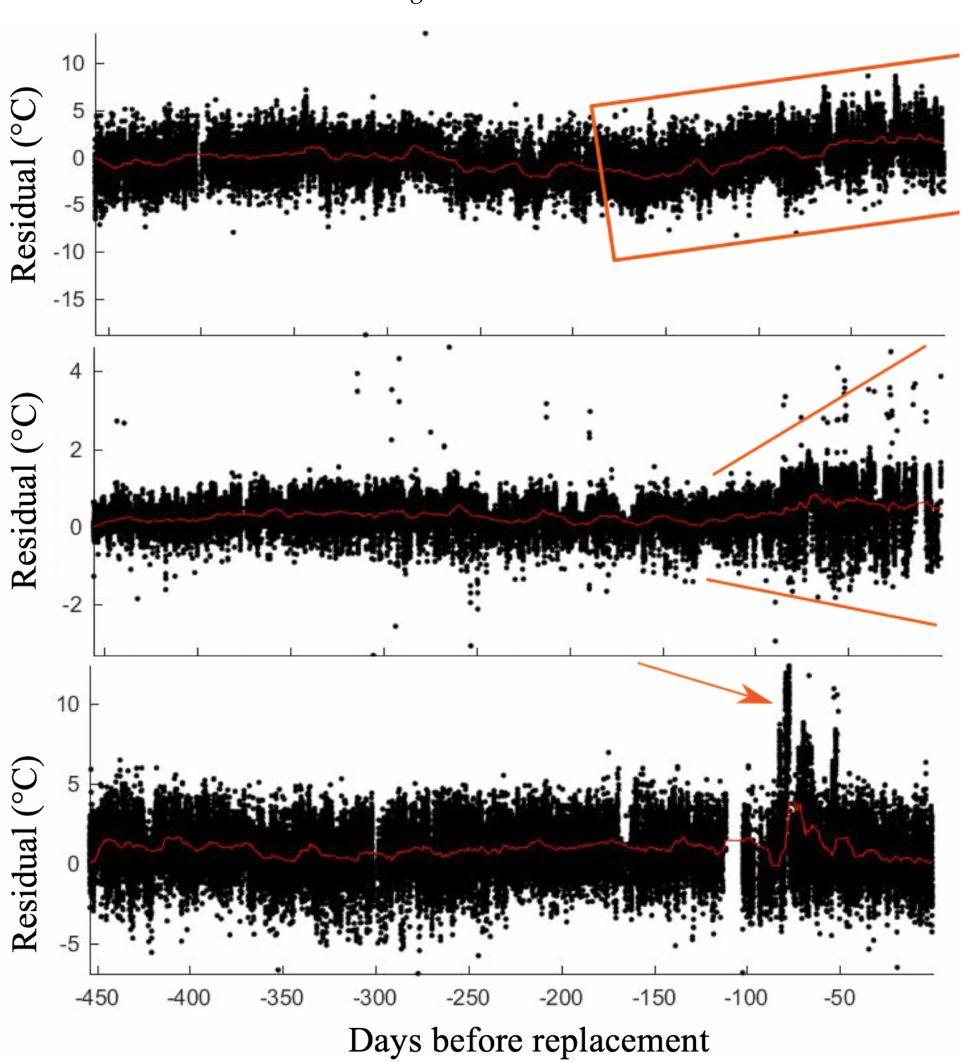
Figure 2. Possible type of patterns which can occur in residuals associated to a turbine component with abnormal behavior. The top panel figure shows a trend increment, the middle one shows an increase in variability, and a spike is shown in the bottom panel (image taken from